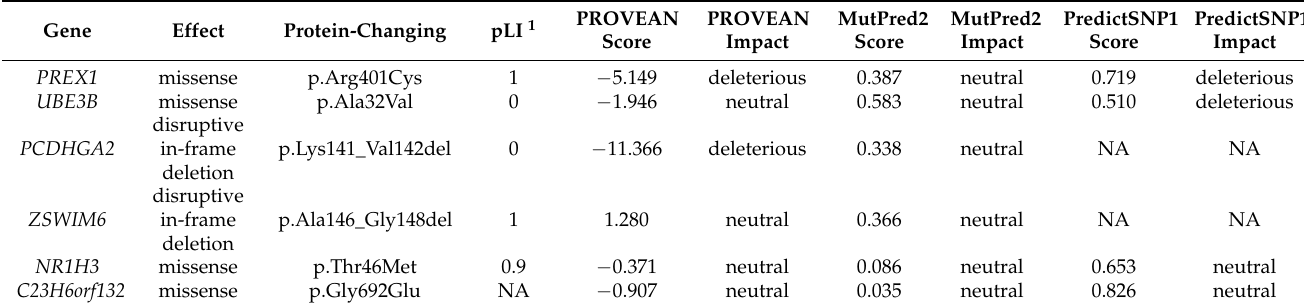
Table 1. Pathogenicity prediction results for the six heterozygous protein-changing variants exclusively present in the genome of the BJA-affected calf and absent in global control cohort of more than 4500 genomes of a variety of